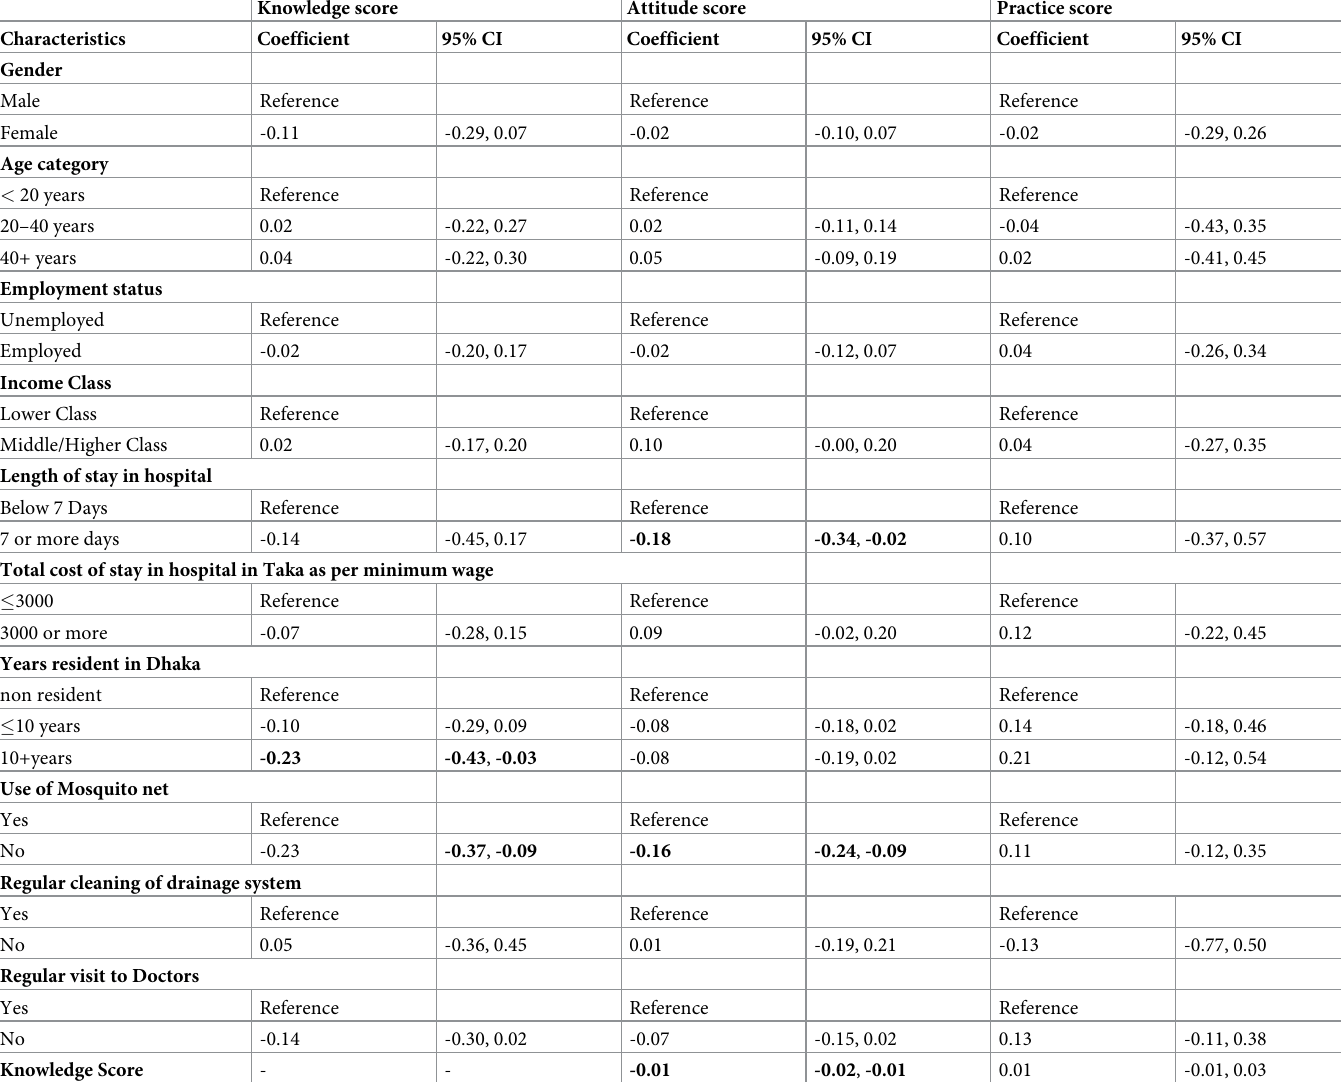
Table 2. Adjusted coefficients and 95% confidence intervals of multivariate analysis for factors associated with knowledge, attitude and practice towards dengue in Dhaka North City Corporation (DNCC),